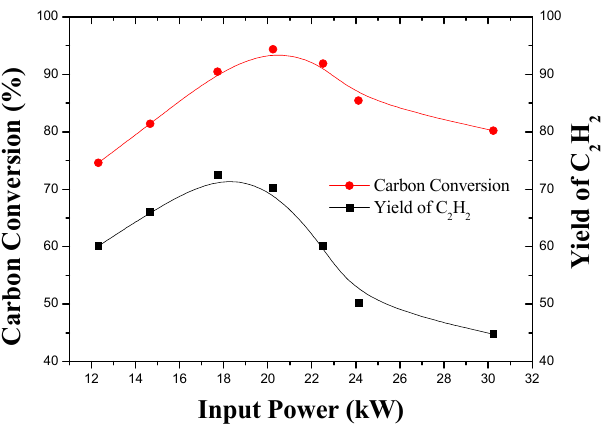
Figure 11. Variation in the selectivity of C 2 H 2 with varied input power (Carrier gas flow rate: 1 Nm 3 /h; working gas flow rate: 5 Nm 3 /h; feed rate: 17.65 g/min; magnetic flux intensity: 0.077 T).